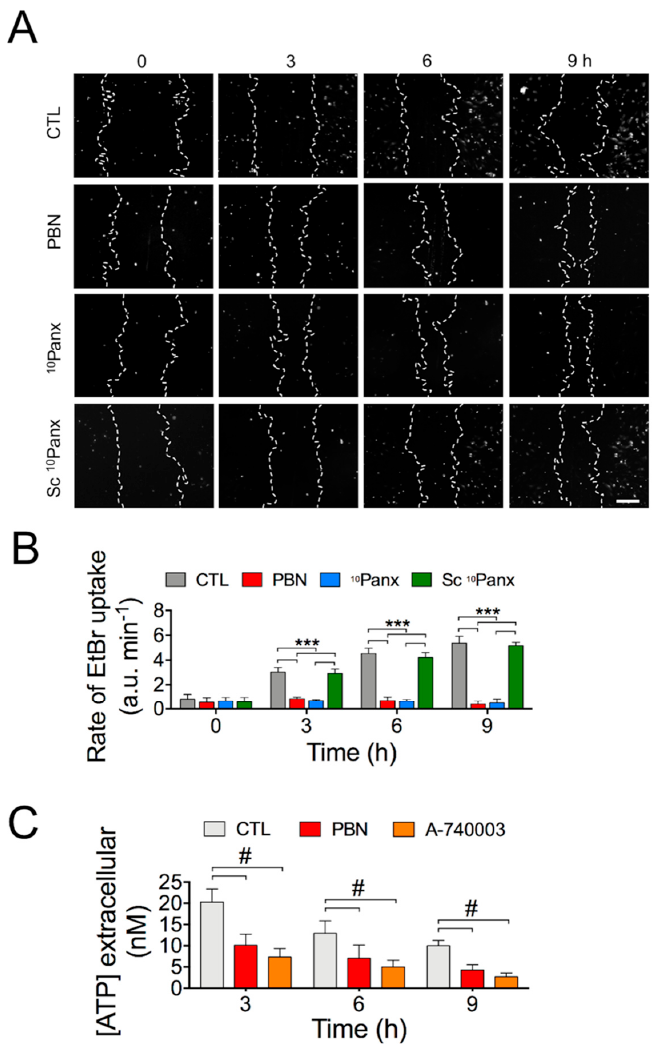
Figure 3. Activity of Panx1 channels during wound closure in HDFs. ( A ) Representative fluorescent images of Ethidium (Etd) uptake by HDF cells treated with 200 µM PBN, 100 µM 10 Panx, 100 µM Sc 10 Panx, or vehicle (Control, CTL). Bar: 200 µm. Supplementary Figure S3A shows these same fluorescent images superimposed with their respective bright-field image. ( B ) Etd uptake rate measure as described in section 4; *** p < 0.001; n = 10 (two-way ANOVA followed by Bonferroni’s post hoc test). ( C ) Measurements of extracellular ATP released from HDFs as a function of time in the presence or absence of 200 µM PBN or 10 µM A-740003. #: *** p < 0.001; n = 10 (two-way